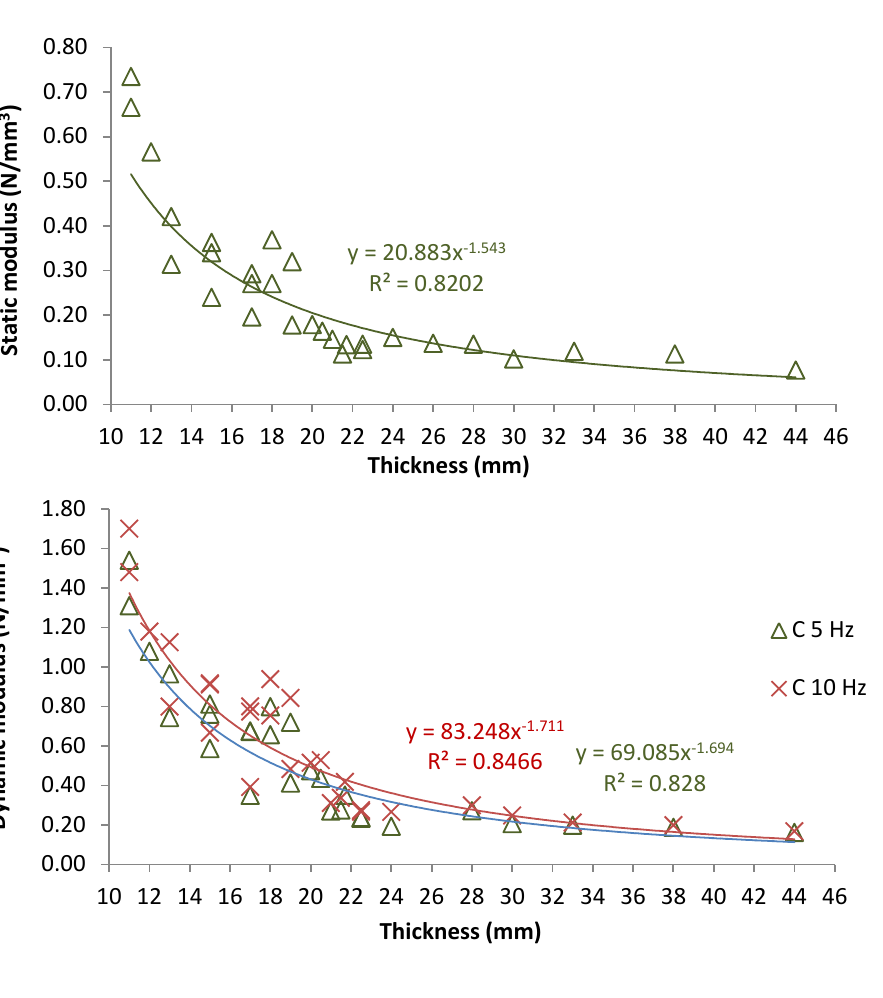
7. Effect of thickness on tire mats mechanical performance, static and dynamic